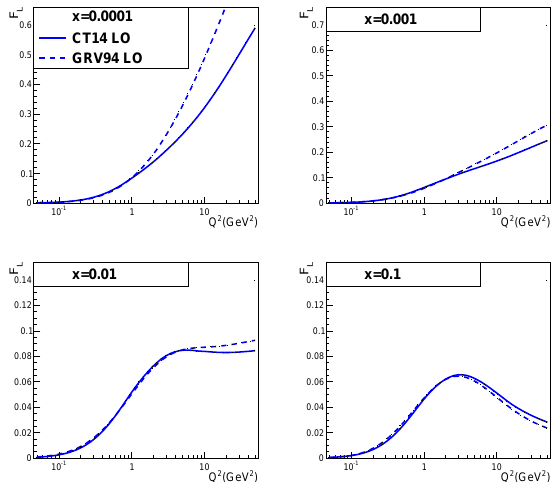
Figure 1: The results from the model for F GRV94LO as a function of Q 2 for fixed values of x